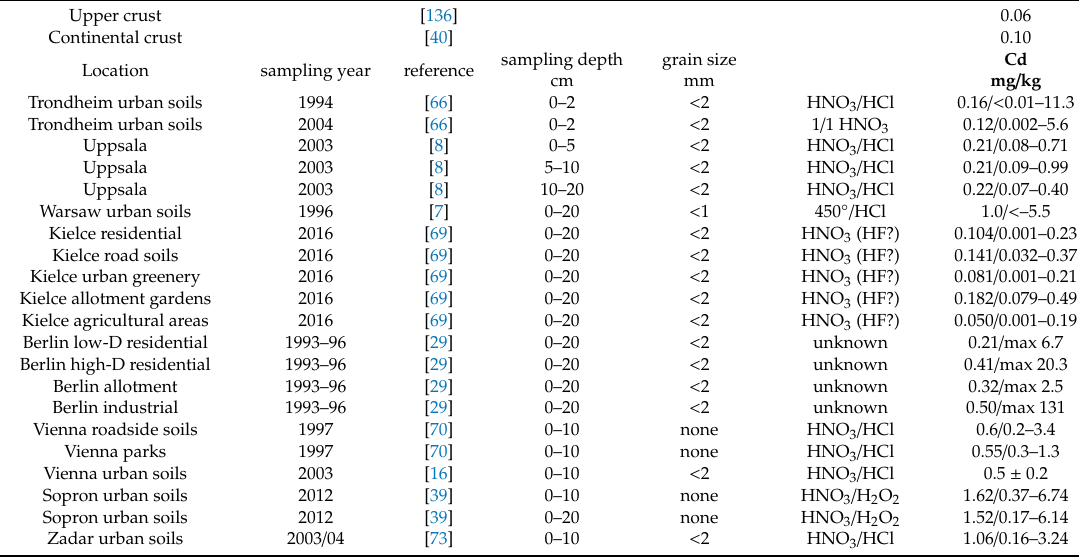
Table A8. Cadmium in urban